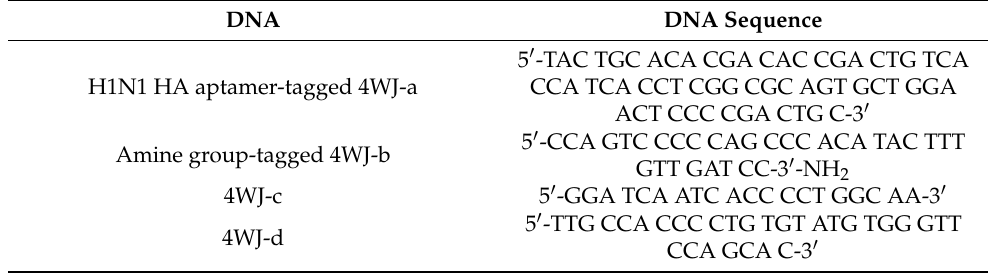
Table 1. DNA sequences.